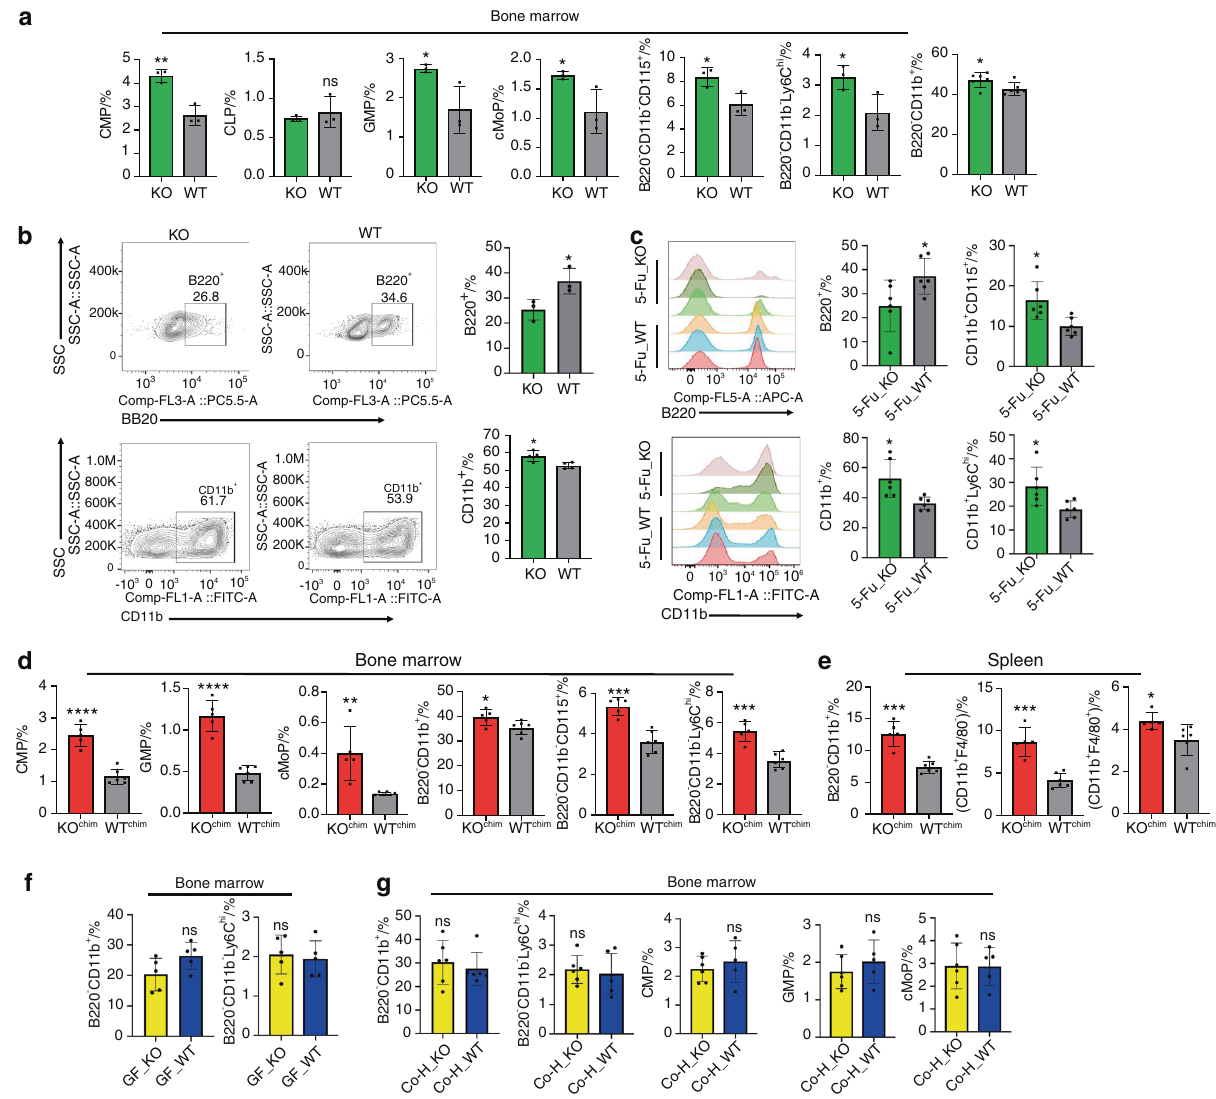
Fig. 6 Myeloid-biased hematopoiesis plays an important role in the in fl ammatory bone loss in TLR9 − / − mice. a Proportion of bone marrow progenitor cells, myeloid cells and osteoclast progenitors in TLR9 − / − and wildtype mice analyzed by fl ow cytometry. n = 3 or 6 per group. The data of B220 - CD11b + cells was pool of results from two independent experiments. In other panels, representative data from one of two independent experiments were shown. b In vitro differentiation of hematopoietic stem cells. LSK + cells were sorted by FACS and cultured in liquid medium under lymphoid (upper panels) or myeloid (lower panles) supportive conditions for 12 or 7 days, respectively. At the end of assay, cells were stained with antibodies to B220 or CD11b to quantify the output of lymphoid or myeloid cells by fl ow cytometry. c Eight- week-old male TLR9 − / − (KO) and wildtype (WT) mice were exposed to the chemotherapy drug 5-FU and populations of bone marrow myeloid cells and B220 + cells were analyzed by fl ow cytometry 12 days after treatment. Left 2 panels, representative histograms showing populations of B220 + cells and CD11b + cells after exposure to 5-FU. Right 4 panels, proportions of myeloid and B220 + cells in bone marrow of KO and WT mice after 5-FU treatment. n = 6 per group in all panels. Flow cytometry analysis of bone marrow ( d ) and splenic ( e ) myeloid cells in the bone marrow chimeric mice models. n = 5 and 6 in KO chim and WT chim group, respectively. f Flow cytometry analysis of bone marrow myeloid cells in the germ-free (GF) mice models. n = 5 per group in all panels. g Flow cytometry analysis of bone marrow myeloid cells in the 12-week-old male and female (sex-matched) cohoused mice. n = 6 in Co – H_KO and Co – H_WT group in all panels. The numbers in all fl ow cytometry results represent the frequencies in total splenocytes, bone marrow cells or cultured cells. Error bars represent the s.d. * P < 0.05, ** P < 0.01, *** P < 0.001, **** P < 0.000 1 and ns P > 0.05; statistical signi fi cance was determined using an unpaired two-tailed t